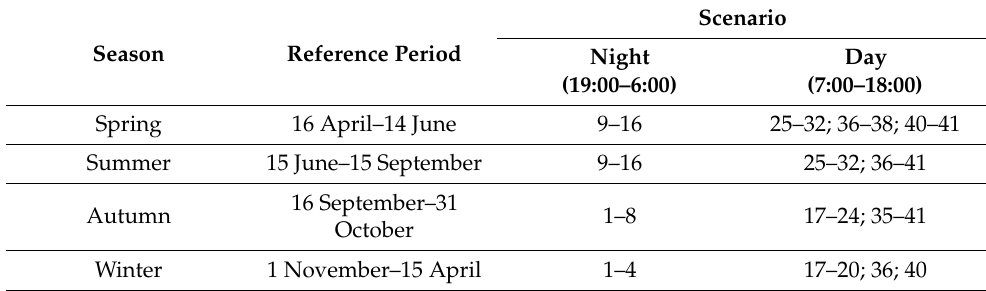
Table 5. Summary of seasonal calculation